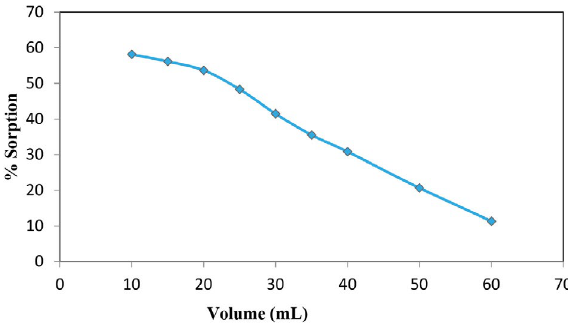
Figure 5. Volume effect for Cr(VI) sorption onto isatin based Am- berlite XAD-2